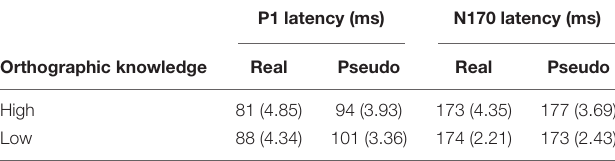
effect or interaction was significant, all F ’s < 1, all p ’s > 0.57, all η 2 < 0.01. p